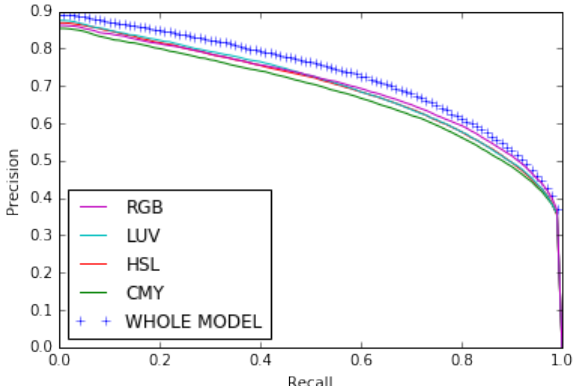
Figure 13. Precision-Recall curves for color spaces RGB, HSL, LUV and CMY and the whole model on the ECSSD